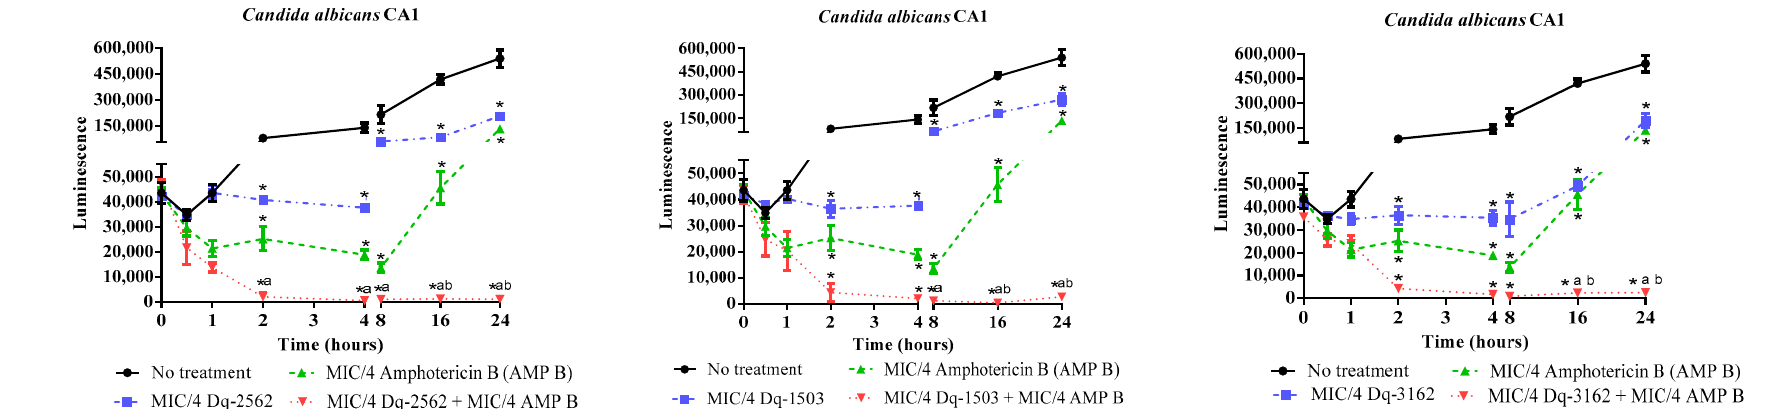
Figure 4. Time-kill effect of D. quadriceps antimicrobial peptides in combination with amphotericin B on the cell viability of Candida albicans CA1. ANOVA and Tukey’s multiple comparisons test. * p < 0.05 (compared to no treatment). a p < 0.05 (compared to subinhibitory concentration of individual peptides alone). b p < 0.05 (compared to subinhibitory concentration of amphotericin B, AMP B).